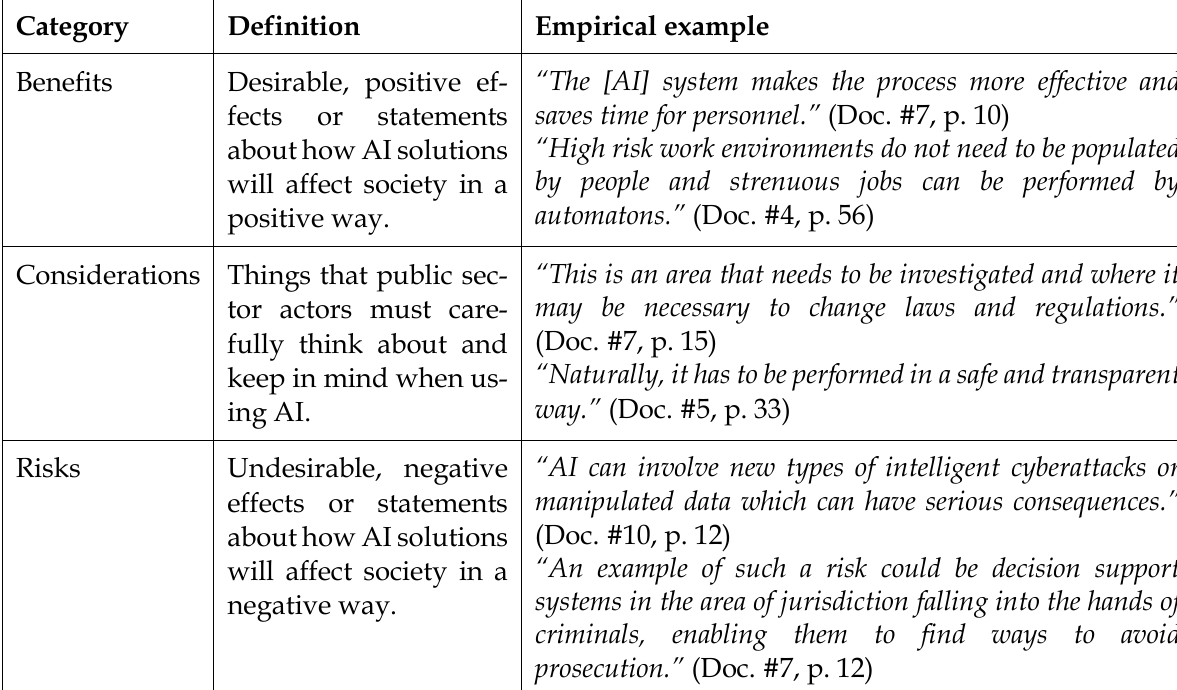
Table 3. The inductively generated categories, with empirical examples (Toll et al.,